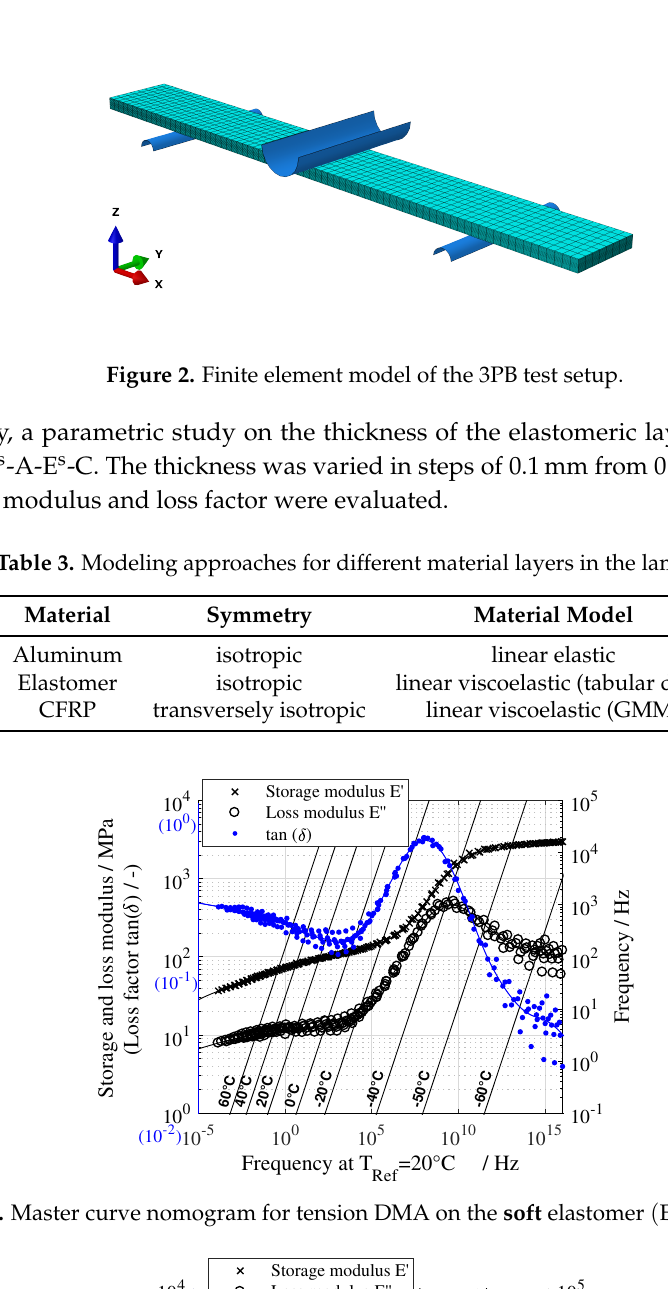
Figure 3. Master curve nomogram for tension DMA on the soft elastomer ( El s